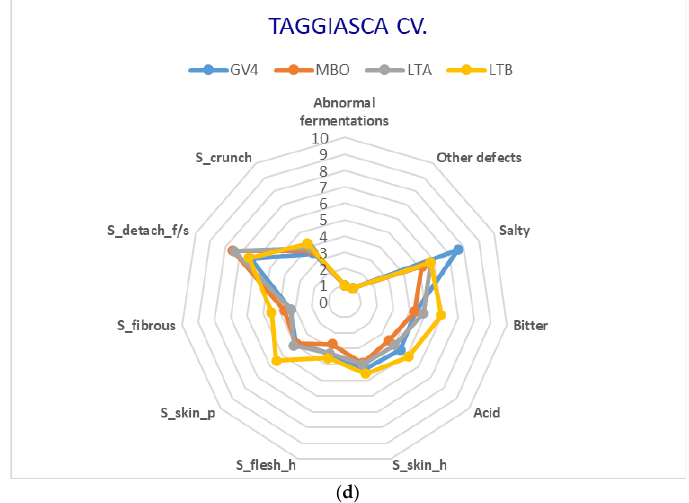
Figure 3. Sensory profiles of samples. ( a ) Bella di Cerignola cv. sensory profiles. ( b ) Nocellara del Belice cv. sensory profiles. ( c ) Itrana cv. sensory profiles. ( d ) Taggiasca cv. sensory profiles. From the sensory profiles, the six parameters related to the kinaesthetic properties were used to build a matrix together with the textural data obtained with the instrument. The considered matrix, as described in paragraph 2.4, was treated at several levels. First, the normality and homoskedasticity of the obtained data were verified to better under- stand which statistical tests were more appropriate for further detailed data analyses. By performing the preliminary tests, we observed that most of the variables were normally distributed, except for the parameters “ T_noise ” , “ S_skin p ” and “ S_crunch ” , which re- jected the null hypothesis (Table 3). According to these results, we then proceeded to carry out non-parametric tests.